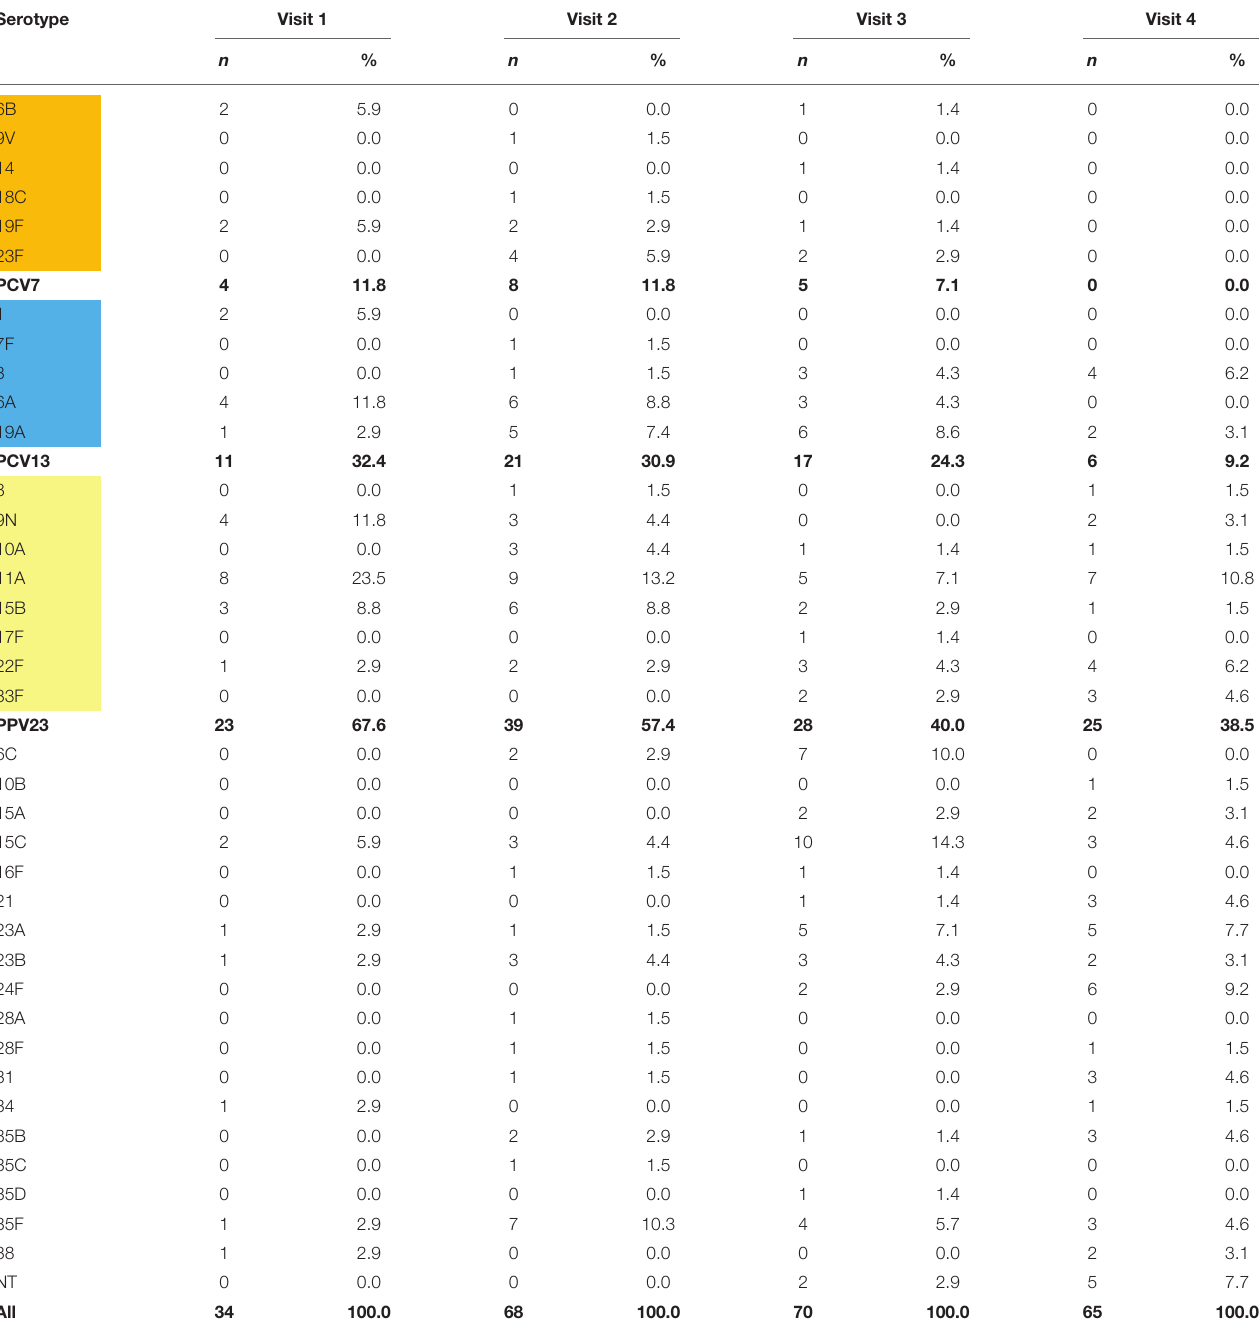
TABLE 4 | S. pneumoniae serotype distribution in the course of the study. Serotype Visit 1 Visit